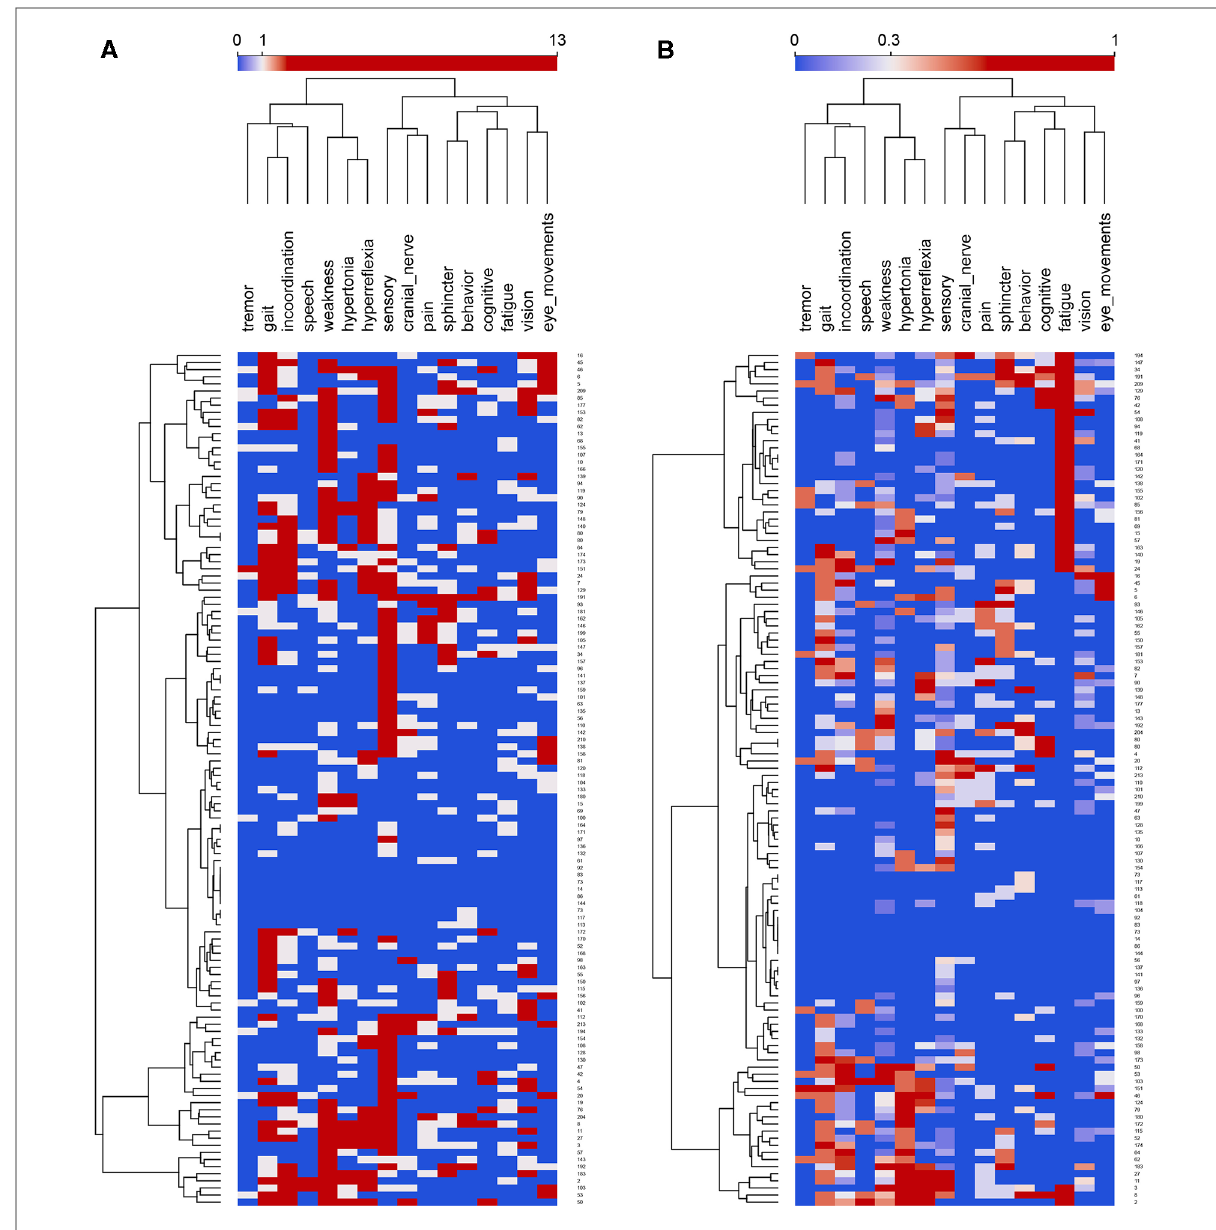
FIGURE 2 ( A ) Feature map of the entire cohort of MS patients before normalization. Rows are subjects, and columns are superclasses. Normalized feature counts in the columns range between 0 to 13 and the color scale is centered on 3 features. Rows and columns are clustered hierarchically with Ward linkage. Column distances by Pearson correlation coef fi cient; row distances are Euclidean. ( B ) Feature map of the entire cohort of MS patients after normalization. Rows are subjects, and columns are superclasses. Normalized feature counts in the columns range between 0 to 1 and the color scale is centered on 0.3 features. Rows and columns are clustered hierarchically with Ward linkage. Column distances by Pearson correlation coef fi cient; row distances are